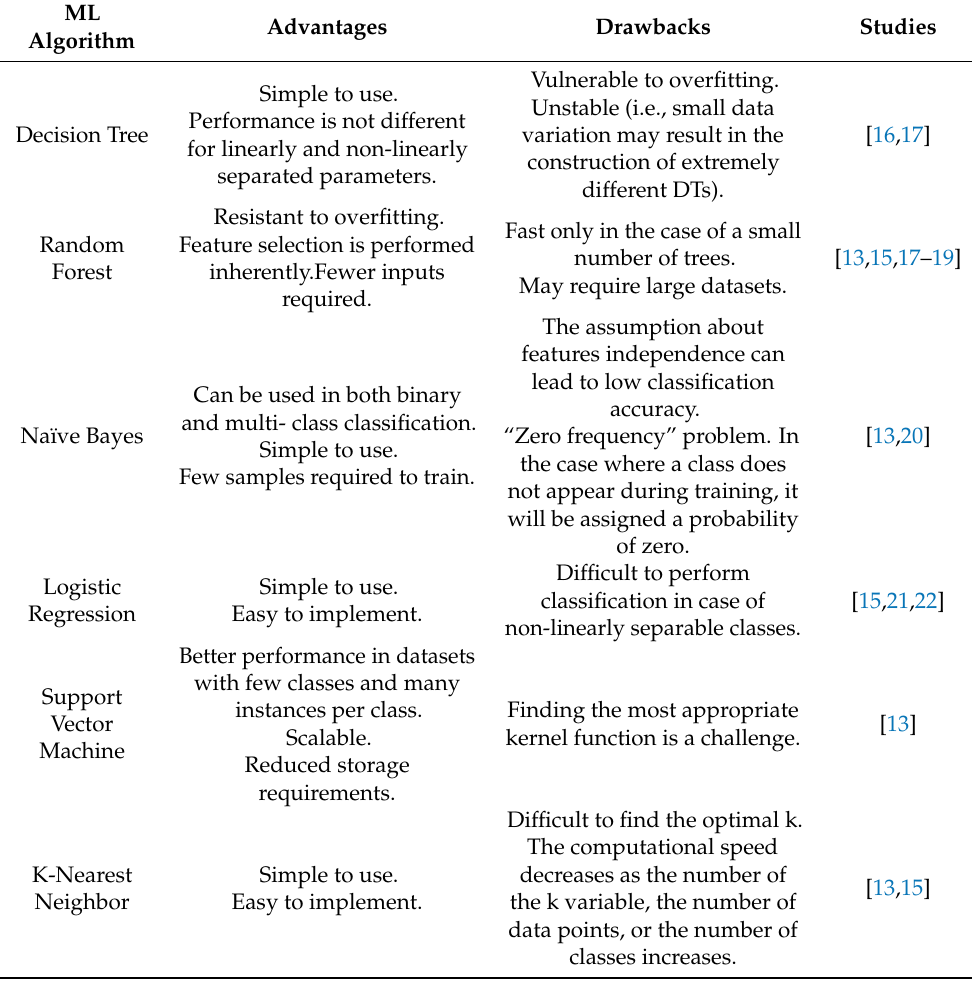
Table 1. Summary of ML algorithms along with their advantages and drawbacks and associated